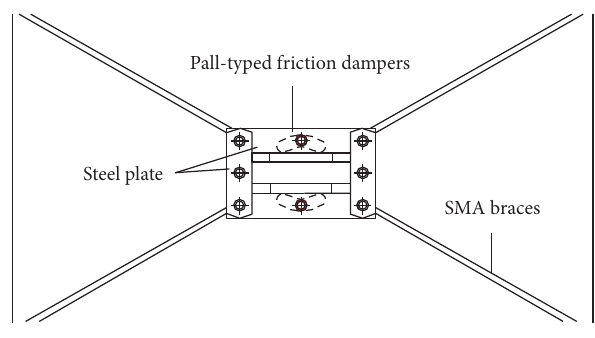
Figure 3: PFD-SMA brace system.